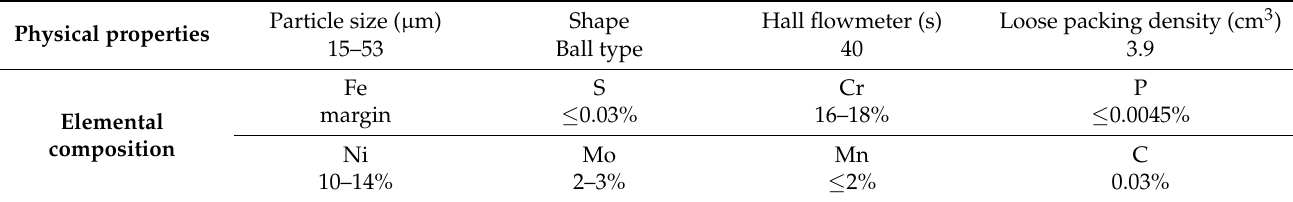
Table 2. The stainless-steel metal powder parameters.